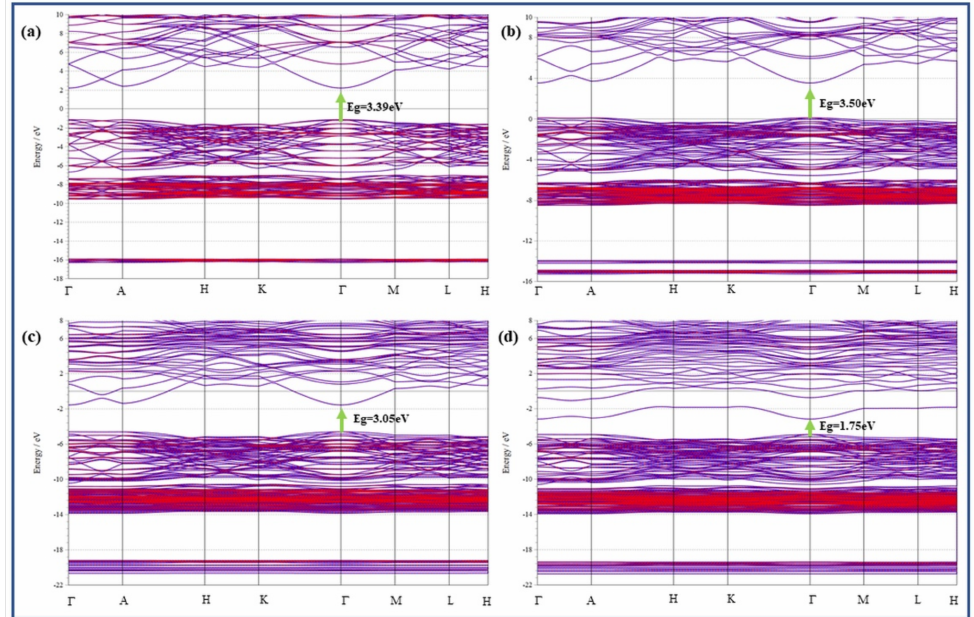
Figure 6. Band structures of ( a ) Zn 16 O 16 , ( b) Zn 15 LiO 16 , ( c ) Zn 16 Li in O 16 and ( d ) Zn 16 Li in O 15